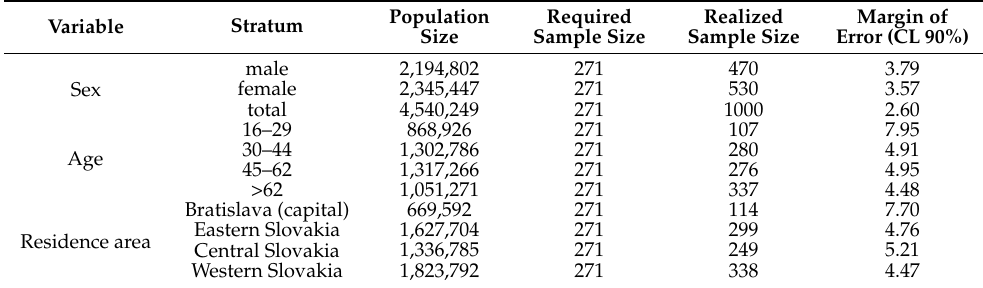
Table 1. Determination of the respondent sample sizes. The required sample sizes were calculated for a 5% margin and 90% confidence level (CL). The realized sample sizes corresponded to the numbers of completed and returned questionnaires. Population size date were obtained from [22].